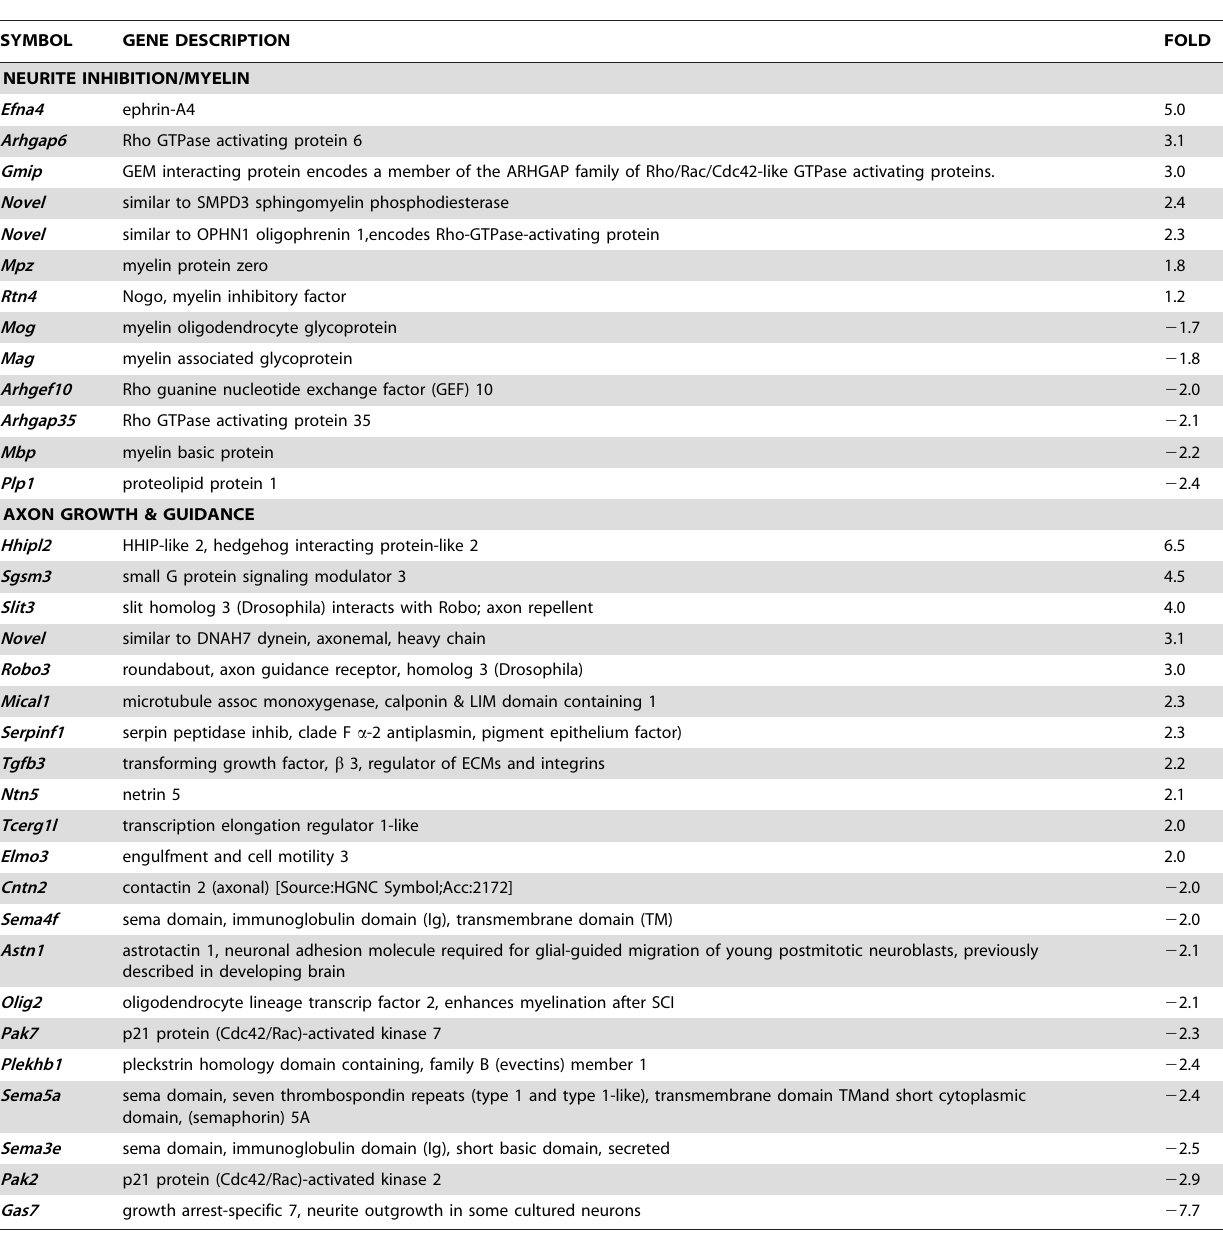
Table 2. Change in expression of neurite inhibitory and axon growth/guidance genes 24 h following spinal cord injury at P28.